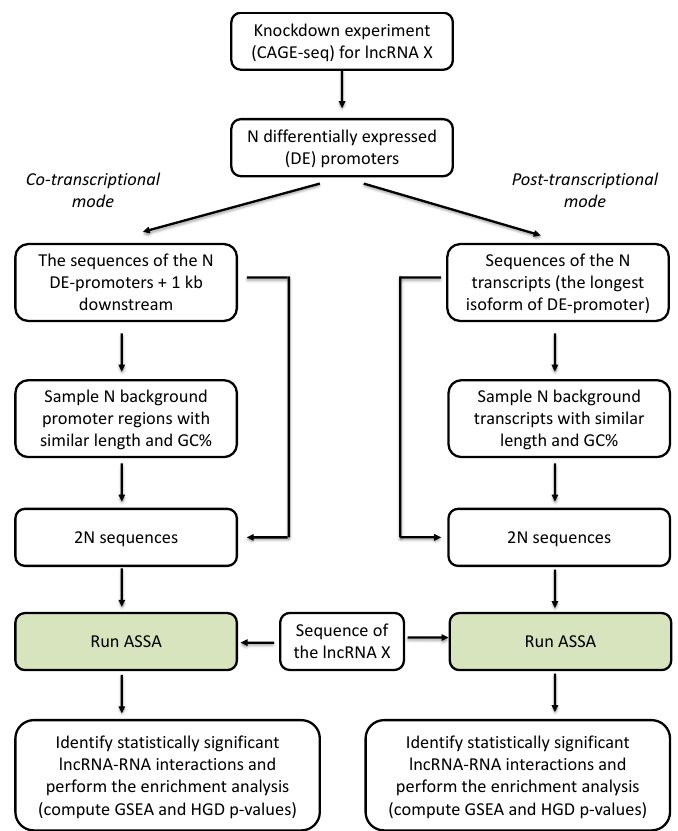
Figure 1. The design of the workflow to detect lncRNAs that may regulate target genes via direct base-pairing co- or